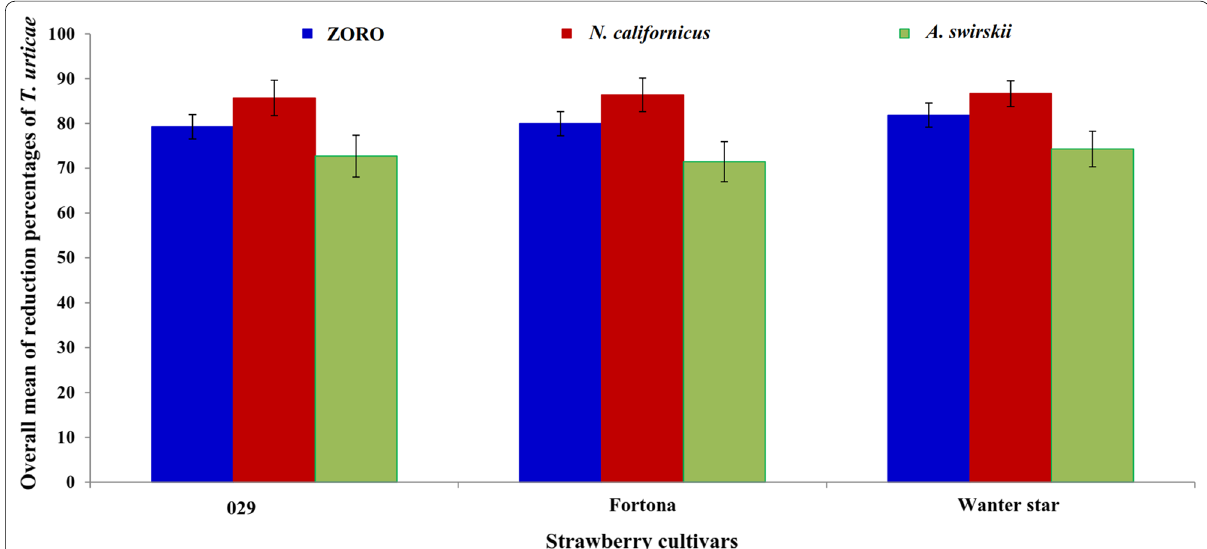
Fig. 3 The overall mean of reduction percentages of Tetranychus urticae on strawberry cultivars after Tetranychus urticae management treatments. The treatments were: Neoseiulus californicus , Amblyseius swirskii release and ZORO